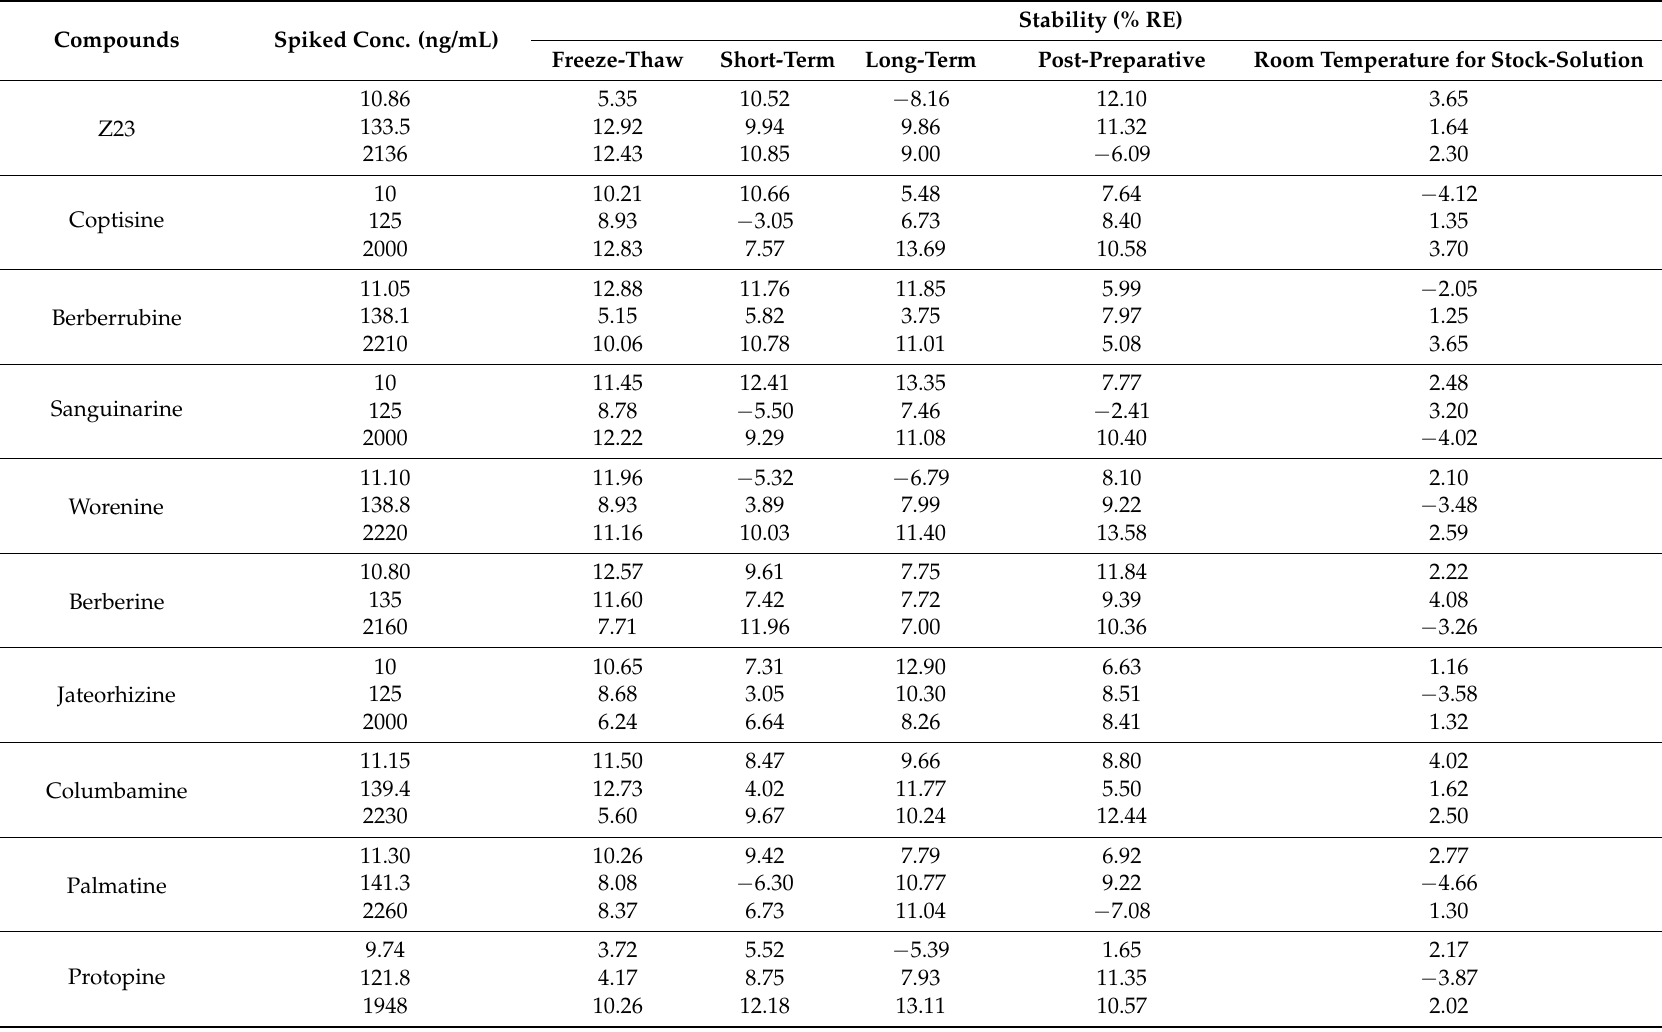
Table 4. Stabilities of the analytes in beagle plasma ( n =